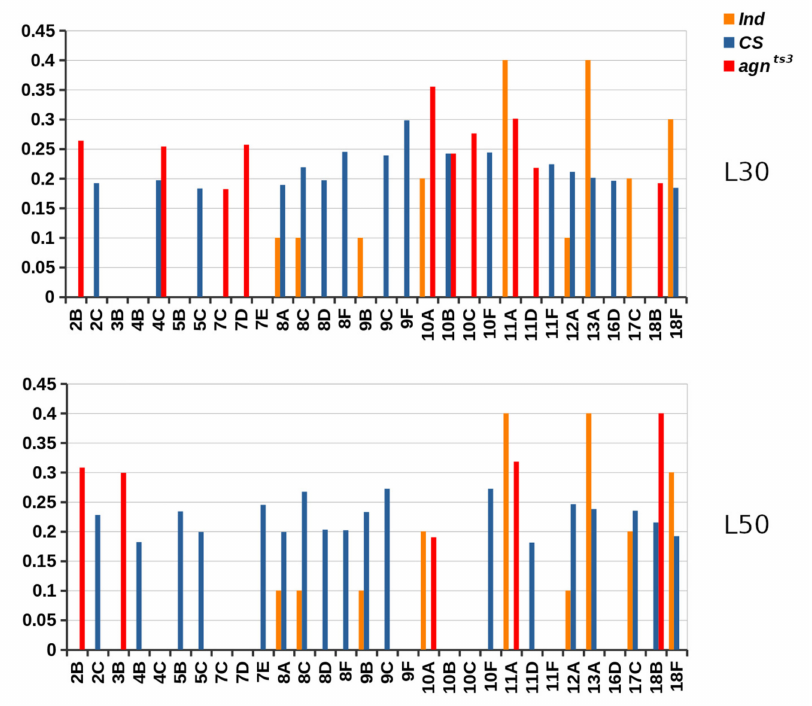
Figure 5. X chromosome sections showing statistically significant FEC-FMF correlations. Ind—the index of chromatin features (F). Y value: R CORR (for CS and agn ts3 ) and Ind values